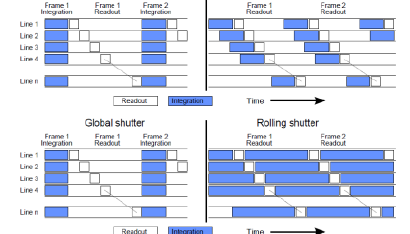
Figure 12. Different acquisition with global and rolling shutter